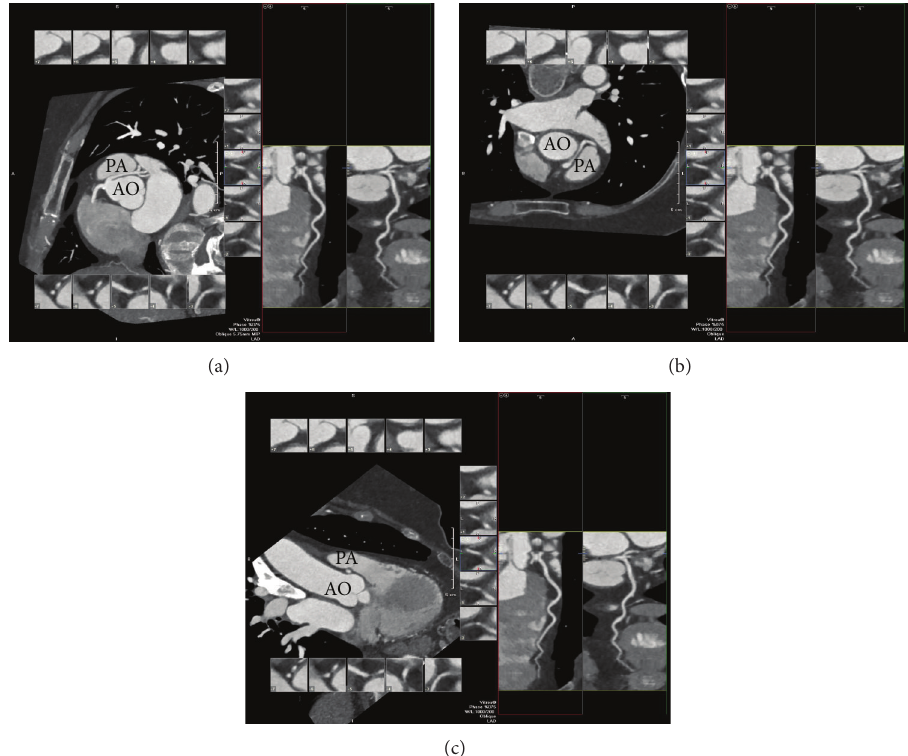
Figure 4: Cardiac computed tomography images of anomalous left main coronary artery off of the right sinus of Valsalva with a course between the pulmonary artery (PA) and aorta (AO).